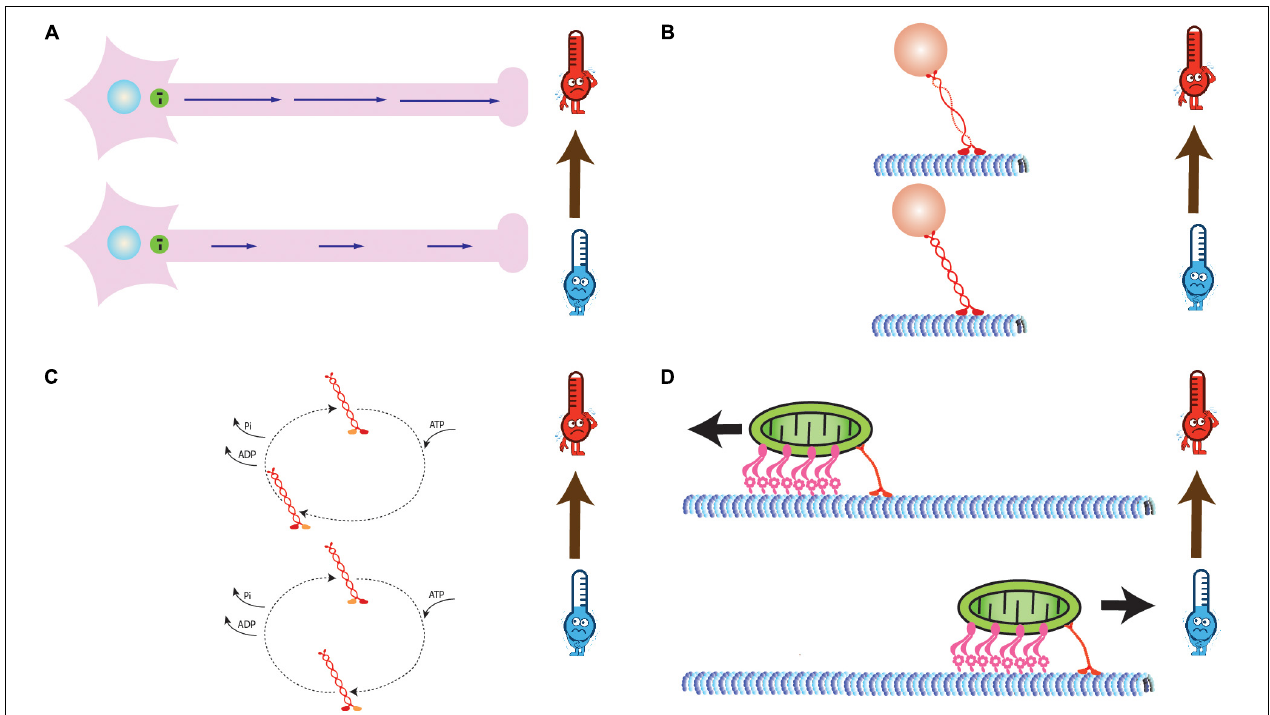
FIGURE 1 | (A) Intracellular transport velocity increases with increase in temperature. The length of blue arrows is proportional to magnitude of transport velocities. (B) Decrease in helicity of stalk domain of motor proteins with increase in temperature (C) Modified biochemical properties of motor proteins (Adenosine triphosphate (ATP) binding, Hydrolysis, and ADP + Pi release rates) due to change in temperature. The size of dashed arrows is proportional to time required for reactions. (D) Reversal of direction of bidirectional transport due to change in temperature dependent biophysical properties of a set of antagonistic motors (Kinesin-1 and